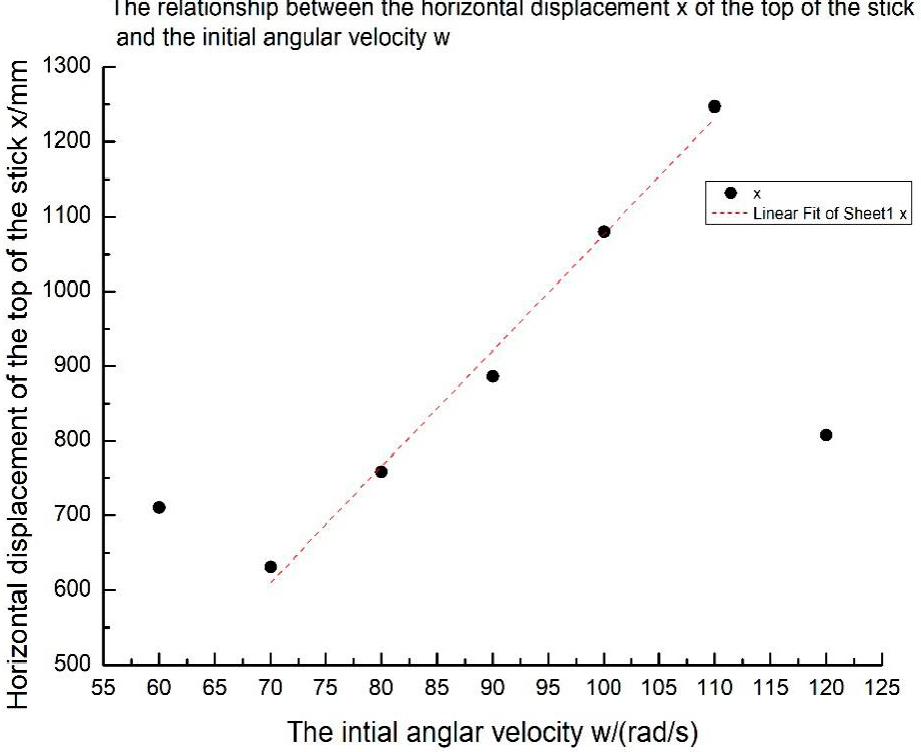
Figure 10. Scatter diagram of horizontal displacement at the top of the lower rod with different initial angular velocities.